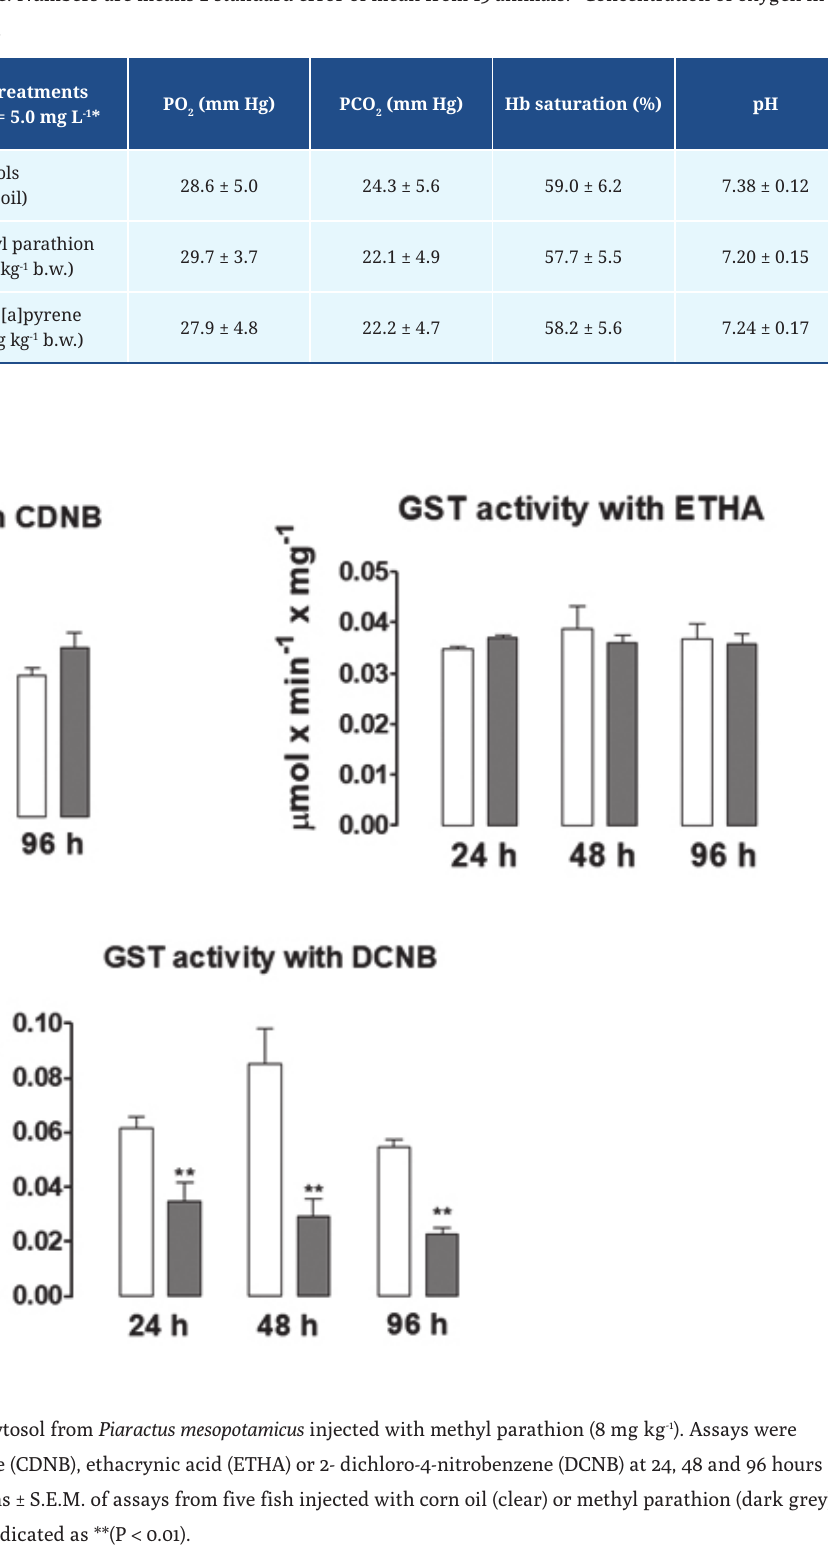
), oxygen saturation 2